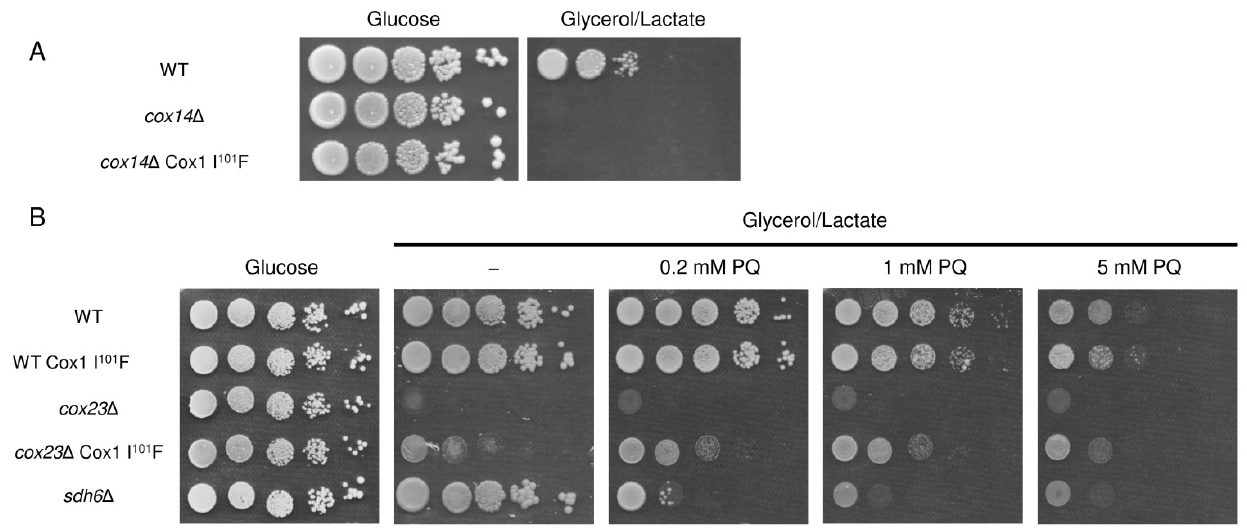
FIGURE 6: Cox1 I 101 F is unable to restore respiratory growth of cox14 ∆ cells. (A) COX14 was either deleted in a WT strain or in a cox23 ∆ sup- pressor strain. High-copy or low-copy plasmids containing COX23 were transformed to cox14 ∆ cox23 ∆ deletion strain to make the strain a cox14 ∆ containing C OX1 suppressor mutation. The resulting cells were tested for respiratory growth. (B) cox23 ∆ mutant cells with and without the Cox1 I 101 F allele were plated on glycerol/lactate medium containing increasing concentrations of paraquat (0 - 5 mM) at